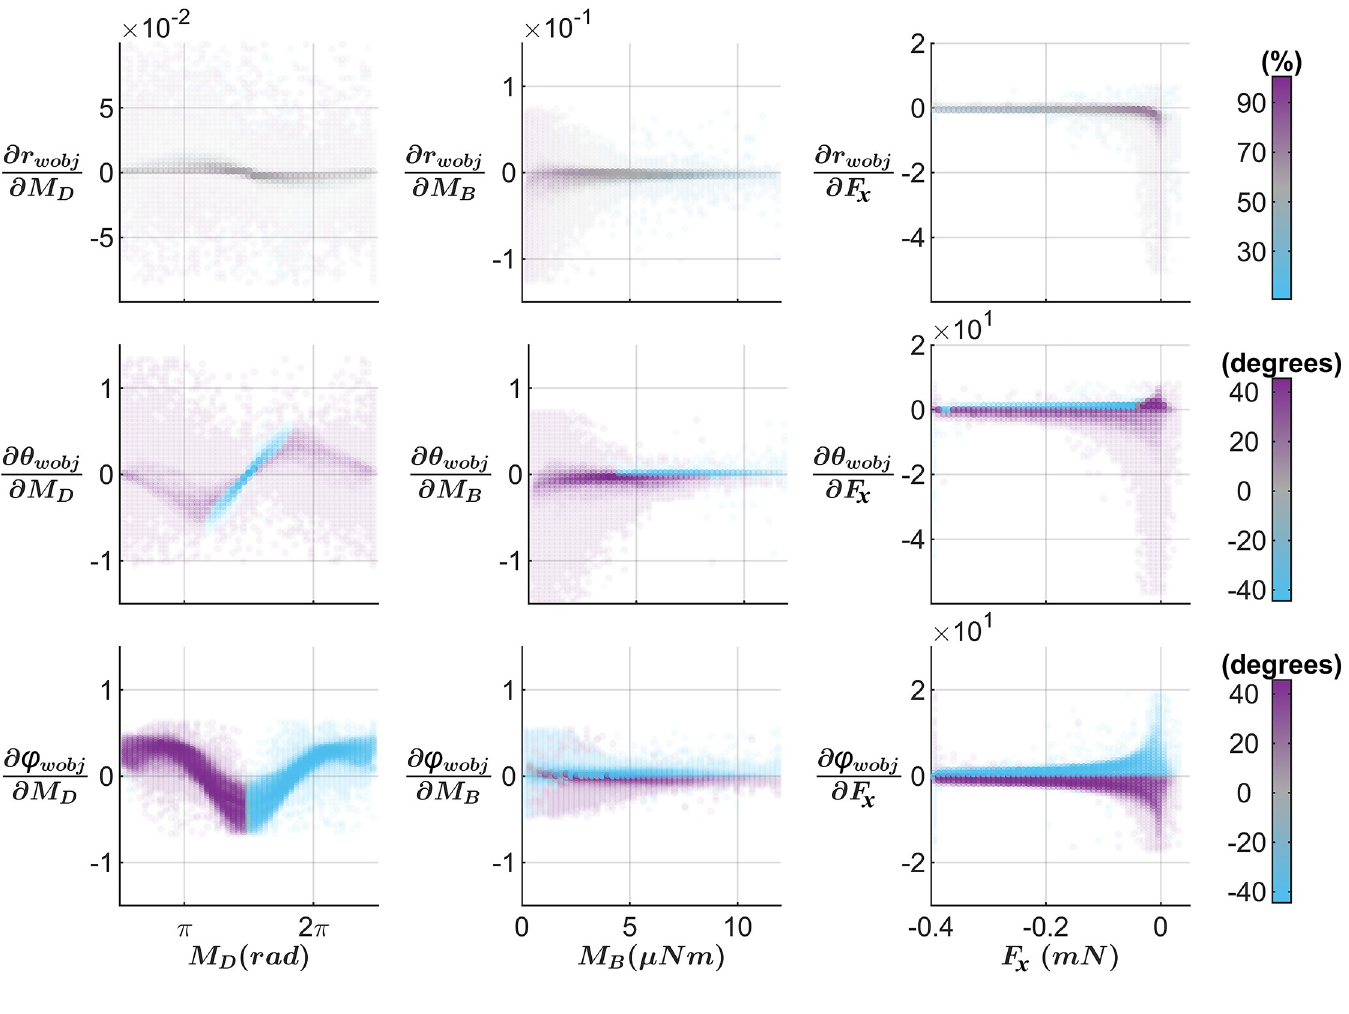
Fig 5. The mapping between contact point coordinates and mechancial variables is most sensitive at small values of F the contact point estimation is to small changes in mechanical variables. Each panel plots a single Jacobian element from Eq 5 against its corresponding mechanical variable, with the colormap determined by its corresponding contact point coordinate. Thus, all panels in a single column share the same x-axis and all panels in a single row share the same color map. From top to bottom, the colormaps indicate percent of whisker arclength, degrees in θ wobj , and degrees in φ wobj